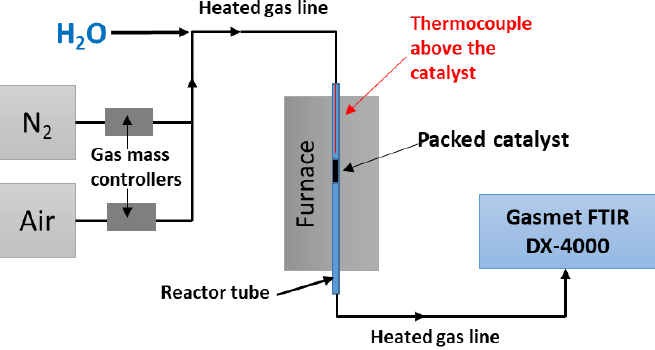
Figure 8. Schematic picture of combustion laboratory test rig.